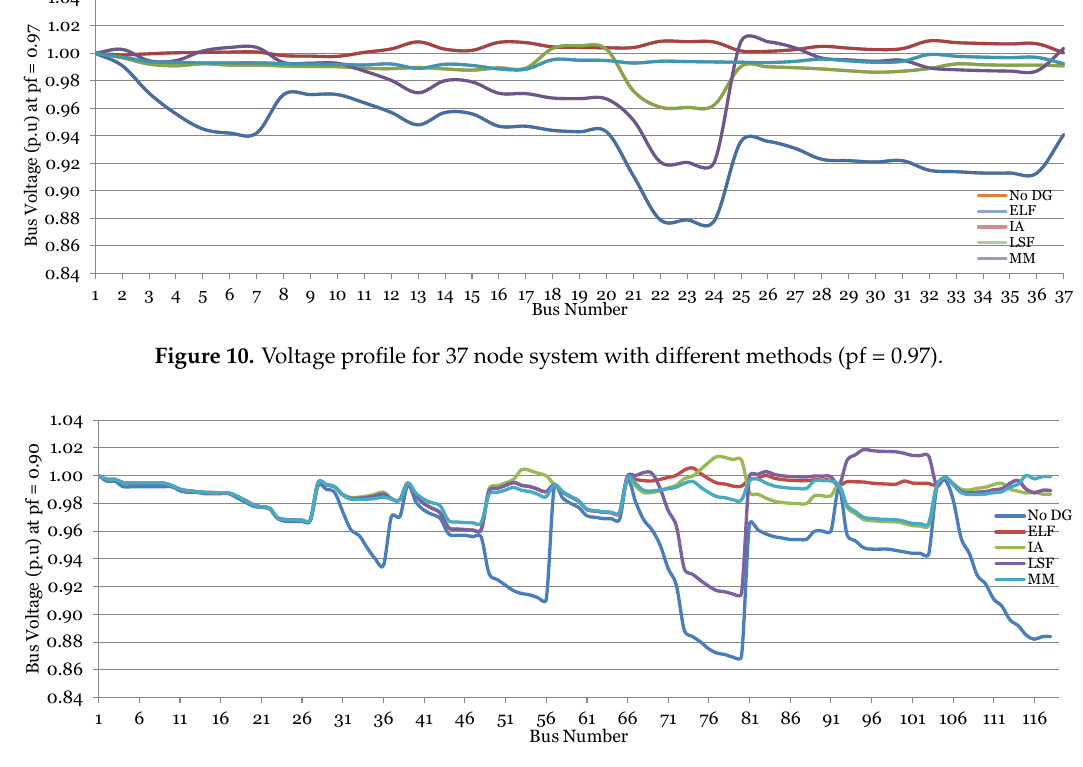
Figure 11. Voltage profile for 119 node system with different methods (pf =